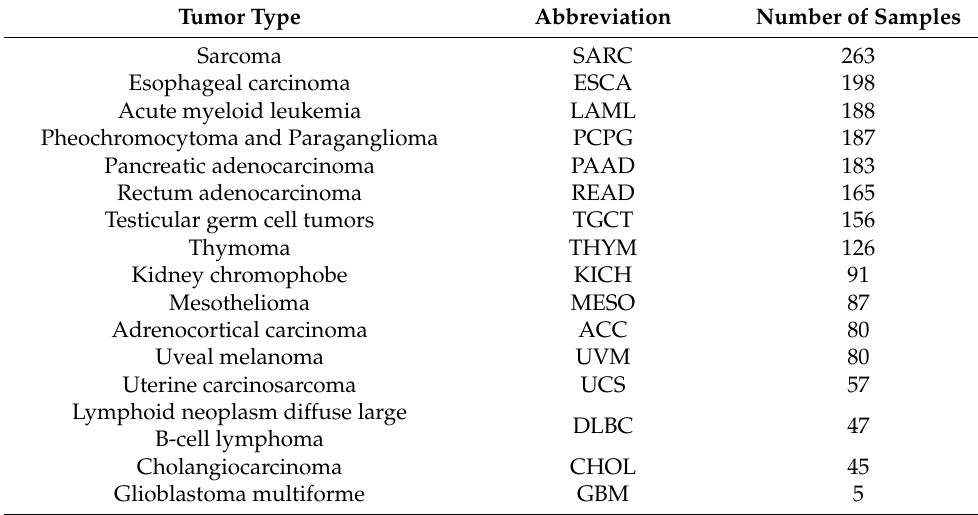
Table 2. Abbreviation for tumor type and the number of genomic data commons (GDC) in The